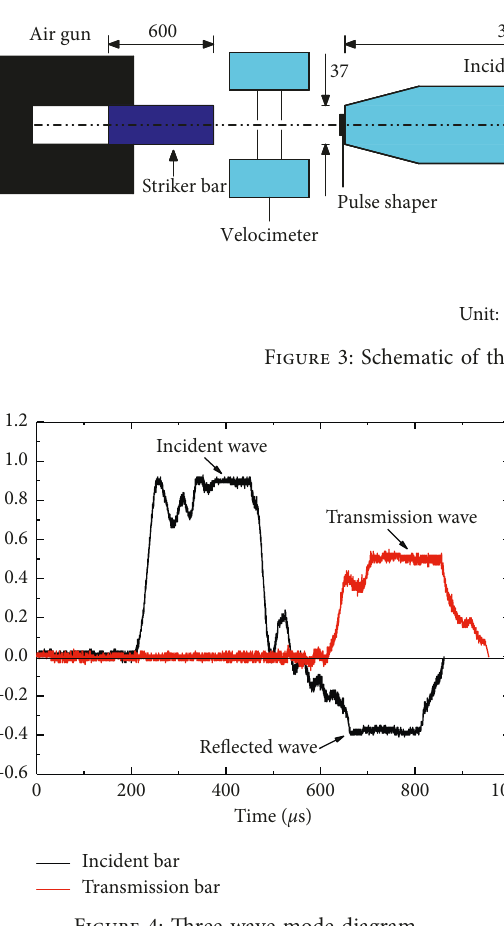
Figure 4: Three-wave mode diagram.